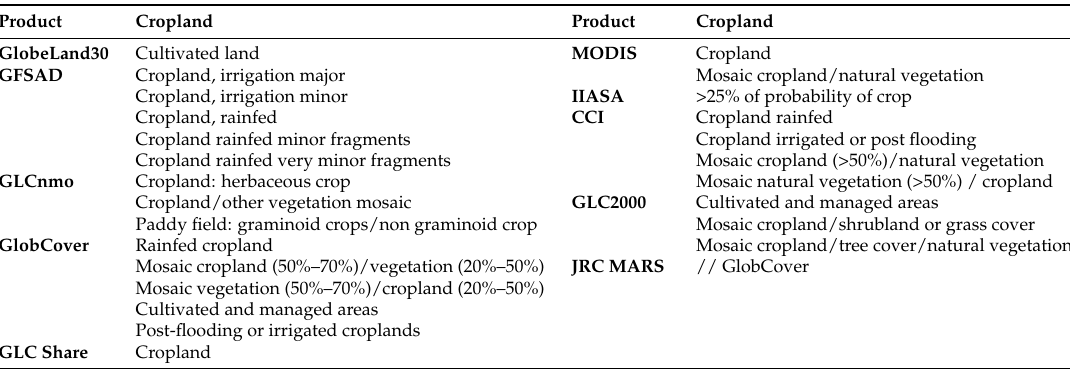
Table 1. Diversity of agriculture-related classes for the 10 previous global land cover maps. GlobeLand 30 is based on Landsat images (30-m); GlobCover and CCI are based on MERIS images (300-m); MODIS and GLCnmo are based on MODIS images (500-m); GLC 2000 is based on SPOT-Vegetation images (1 km); the JRC MARS map hybrid product at 250-m; and IIASA cropland, GLC Share and Global GFSAD hybrid products at